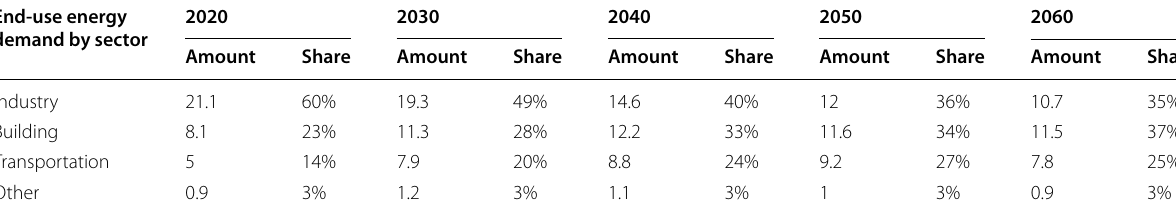
Note: The energy unit is 10 9 tons of standard coal